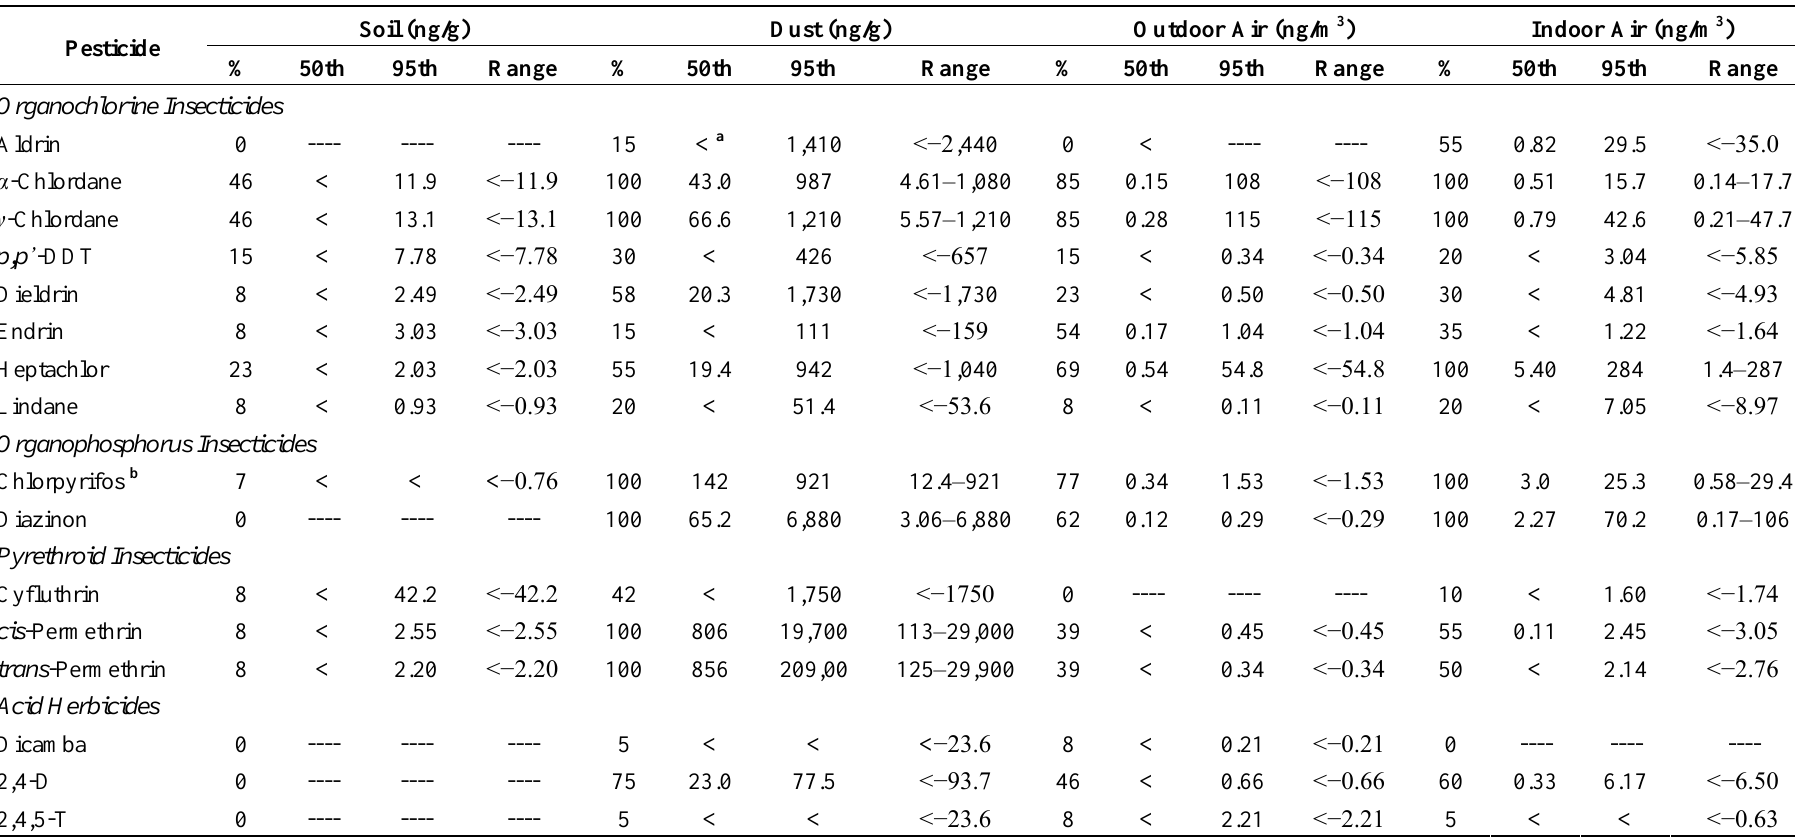
Table 4. Concentrations of pesticides in environmental media collected at 13 child daycare centers in North